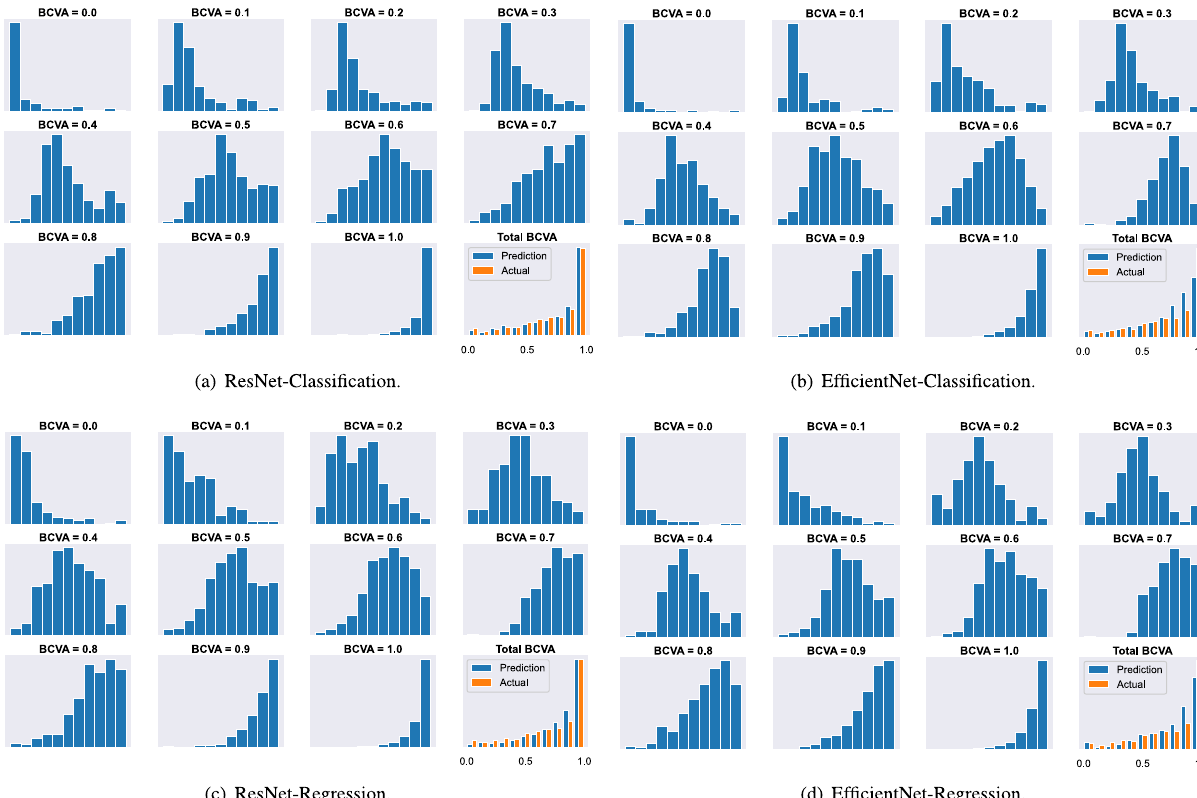
Figure 2. Histograms of considered schemes for each BCVA level. The last subgraph corresponds to the histogram of all prediction results and actual BCVA levels.